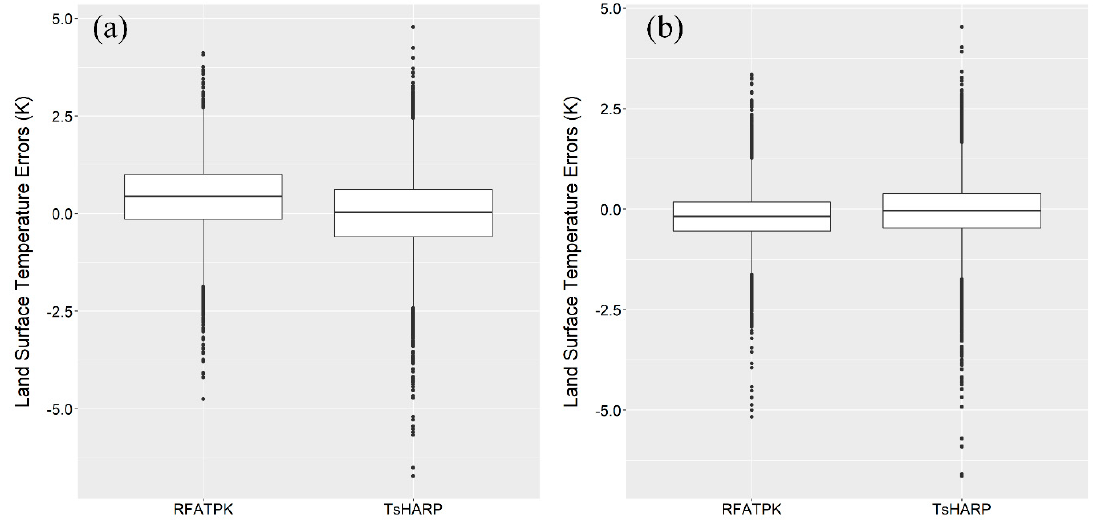
Figure 6. A box plot of RFATPK and TsHARP LST errors in regions ( a ) A and ( b ) B. Figure 6 . A box plot of RFATPK and TsHARP LST errors in regions ( a ) A and ( b ) B.